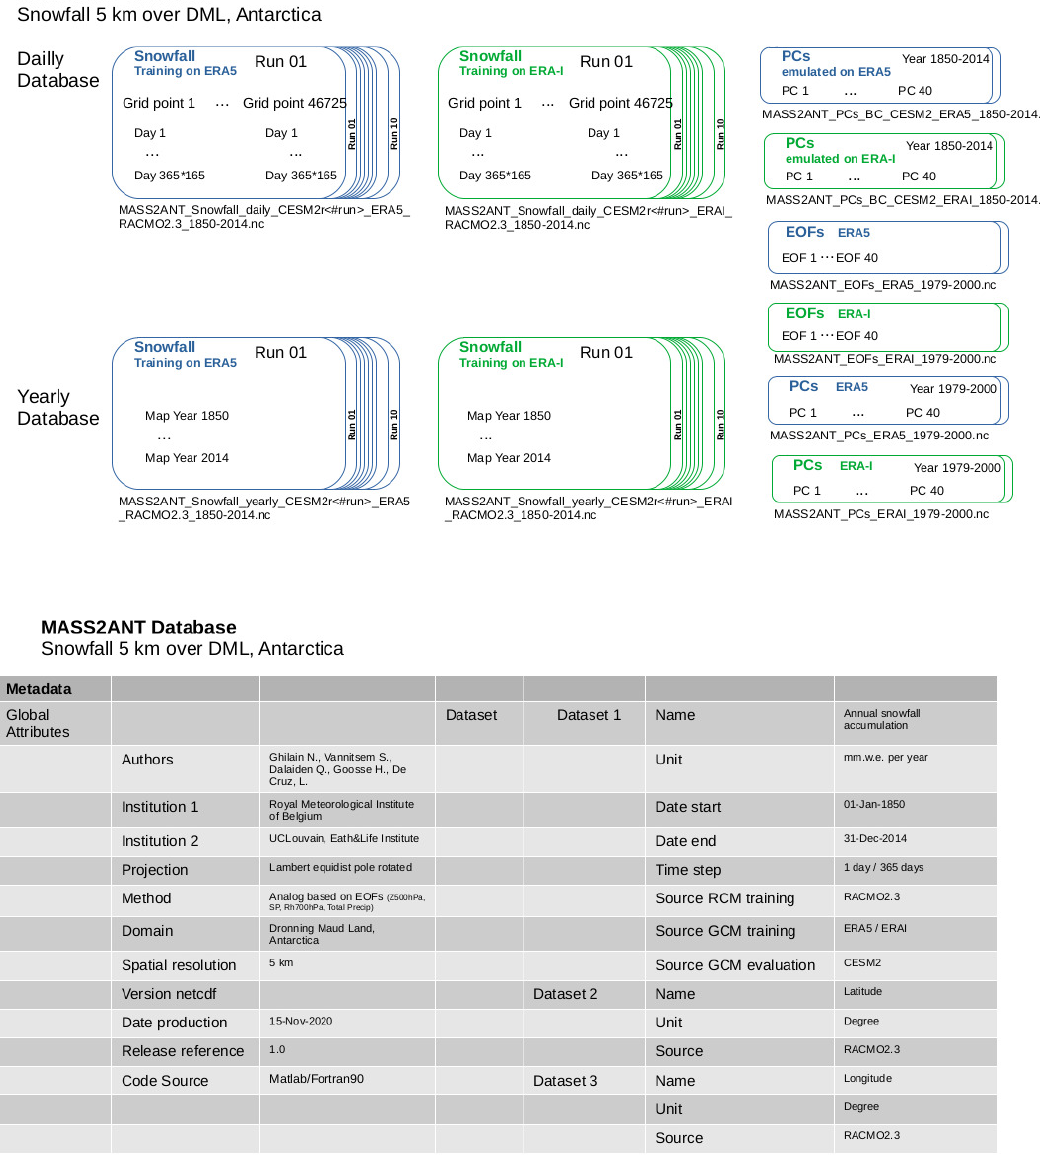
Figure 4. The MASS2ANT database (NetCDF files) includes two files for yearly accumulated snowfall (10 members each) and one per reanalysis used for training. The daily estimations are stored per year and per reanalysis used for training. In addition, PC time series for the 40 EOFs for all the CESM2 members are stored in two separate files as well as the 40 EOFs of the emulated CESM2. Embedded metadata include units, version geographical coordinates and temporal